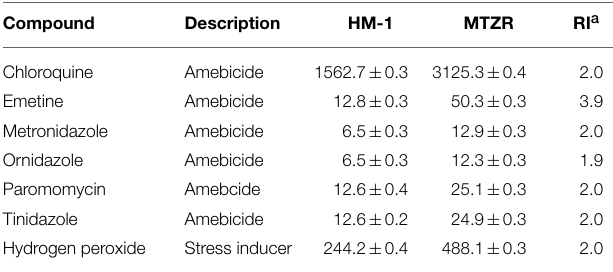
TABLE 1 | IC 50 of drugs used to treat amebiasis and hydrogen peroxide in HM-1 and MTZR.